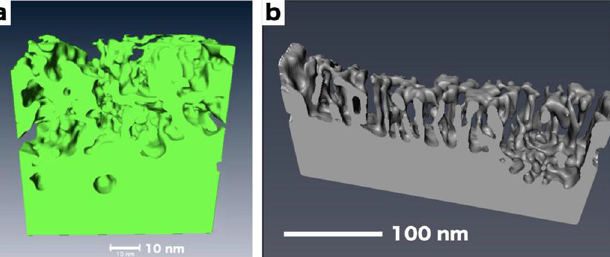
Fig. 6. 3D re-constructed views of (a) NMT1 and (b) NMT2 showing the internal porous structures created on the Al surface.